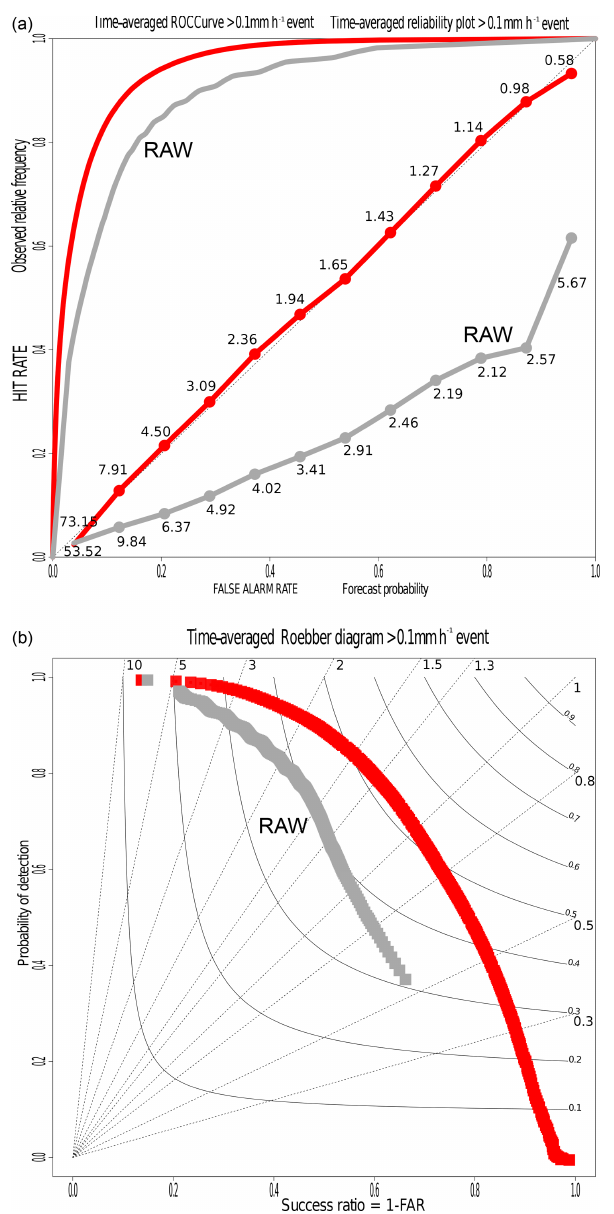
Figure 12. Receiver operating characteristic (ROC) curve and reli- ability diagram (a) and categorical performance diagram (b) for the rain event. In the performance diagram, the background lines rep- resent the frequency bias index and the curves represent the critical success index. The raw ensemble suffers from overprediction. The validation is made by a 2-fold cross-validation on the 2 years of data (one sample per year).